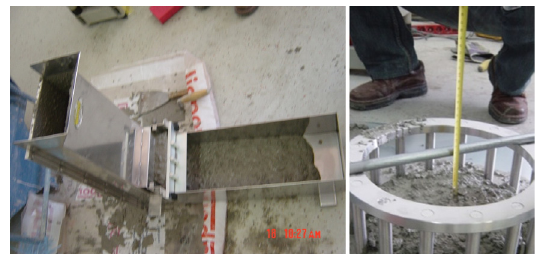
Figure 3. Vibrating during the mixing stage (in the mixer).